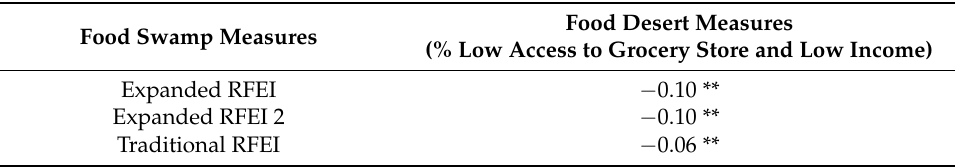
Table 5. Correlations between food swamp and food desert